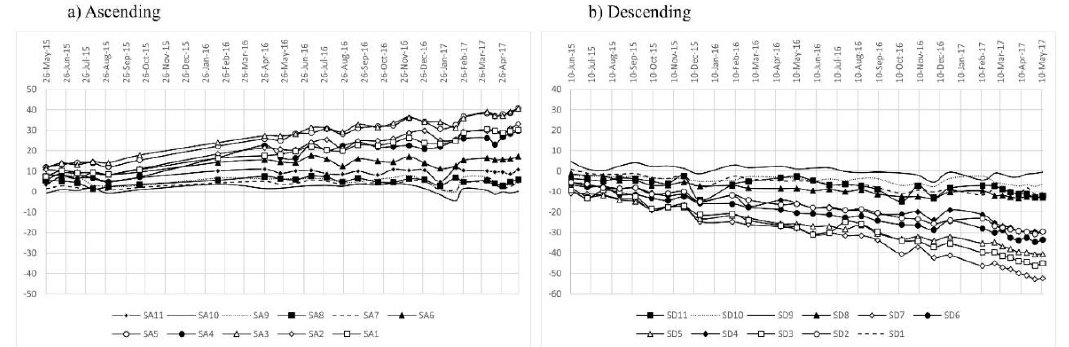
Figure 17. Cumulative LOS displacement between May 2015 and May 2017 at the South Extension landslide by ( a ) Ascending and ( b ) Descending.